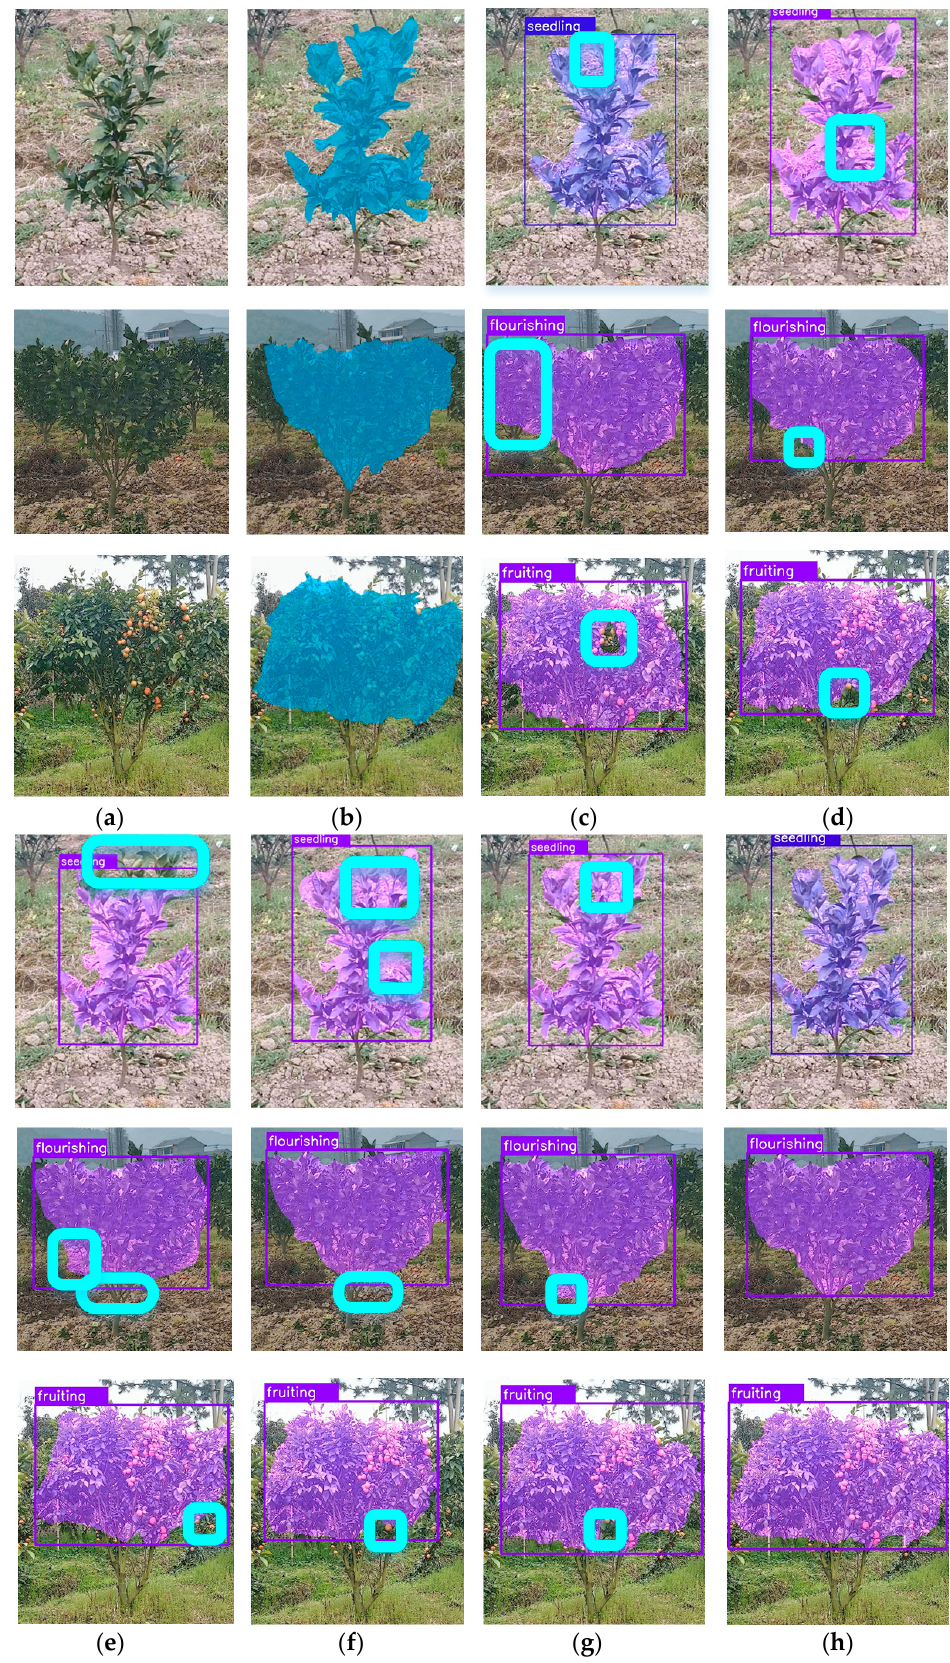
Figure 9. Segmentation effects of different models on Citrus tree-crown at different growth